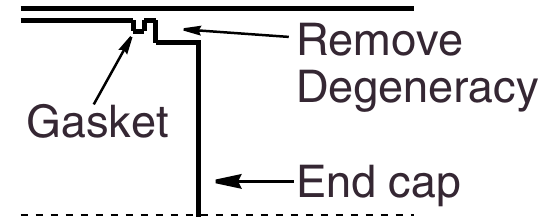
FIG. 7. Close-up of end cap with grooves. Not to scale.